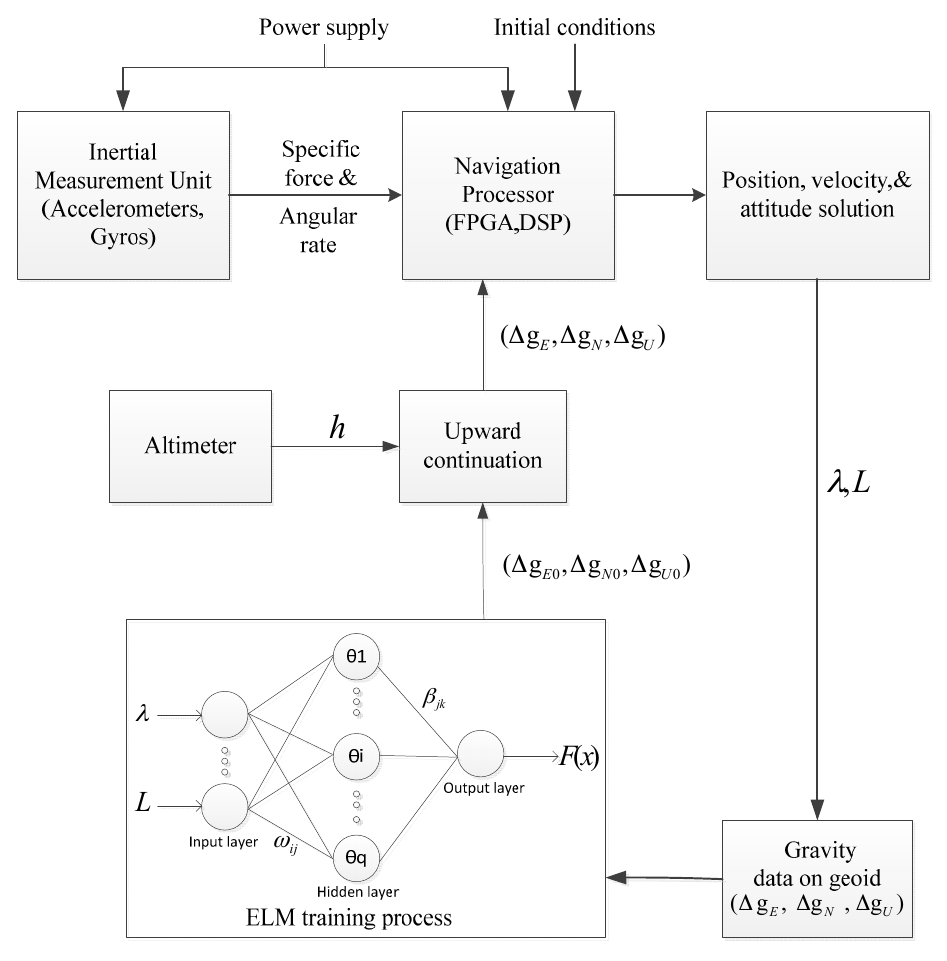
Figure 5. The framework of ELM-based gravity compensation method.